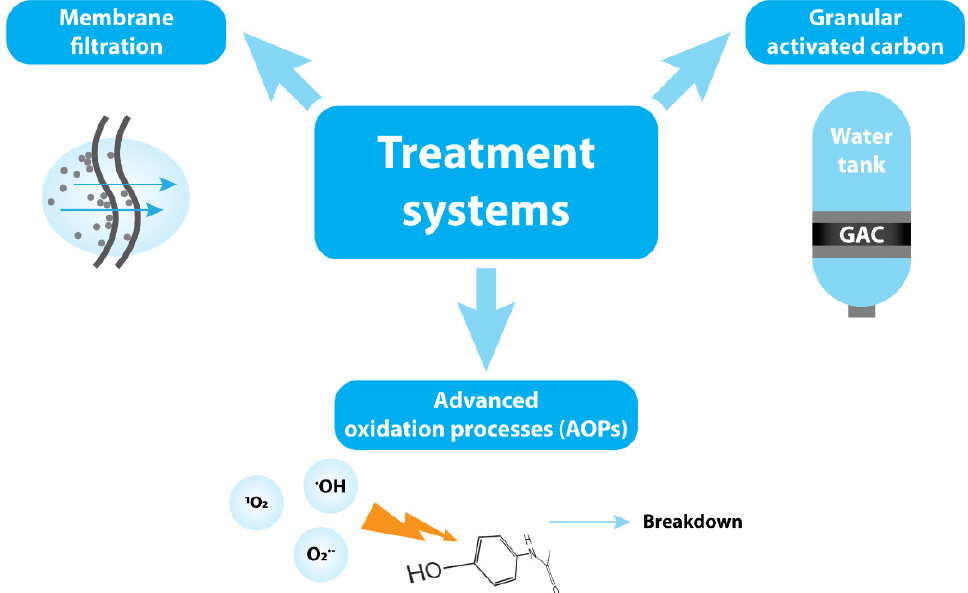
Figure 2. Treatment systems for the removal of individual pharmaceuticals.